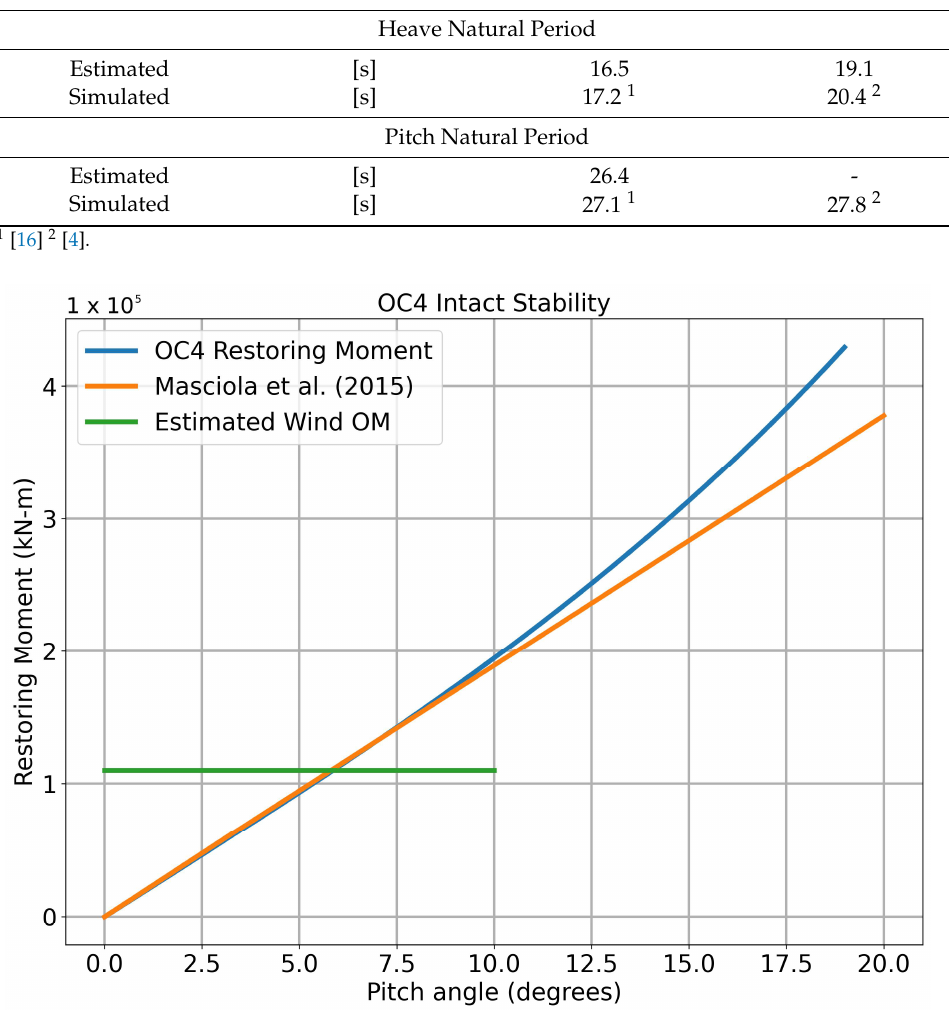
Figure 5. OC4 Floater Intact Stability Curve. Additional data adapted from